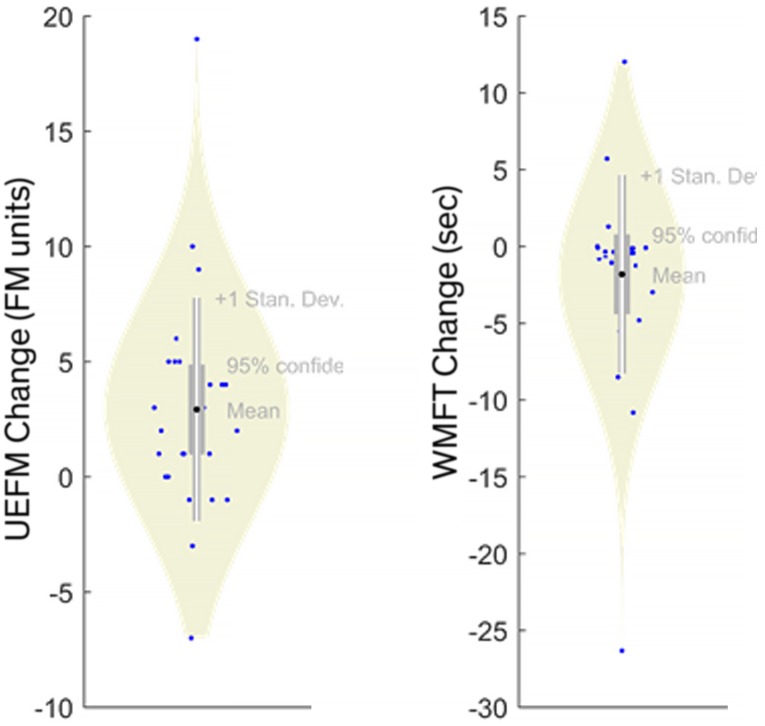
Model output distributions showing sparsity.Both UEFM and WMFT include few (sometimes one) subject(s) representing extreme values of clinical change. Clinical changes for these subjects will be difficult to predict under cross validation.